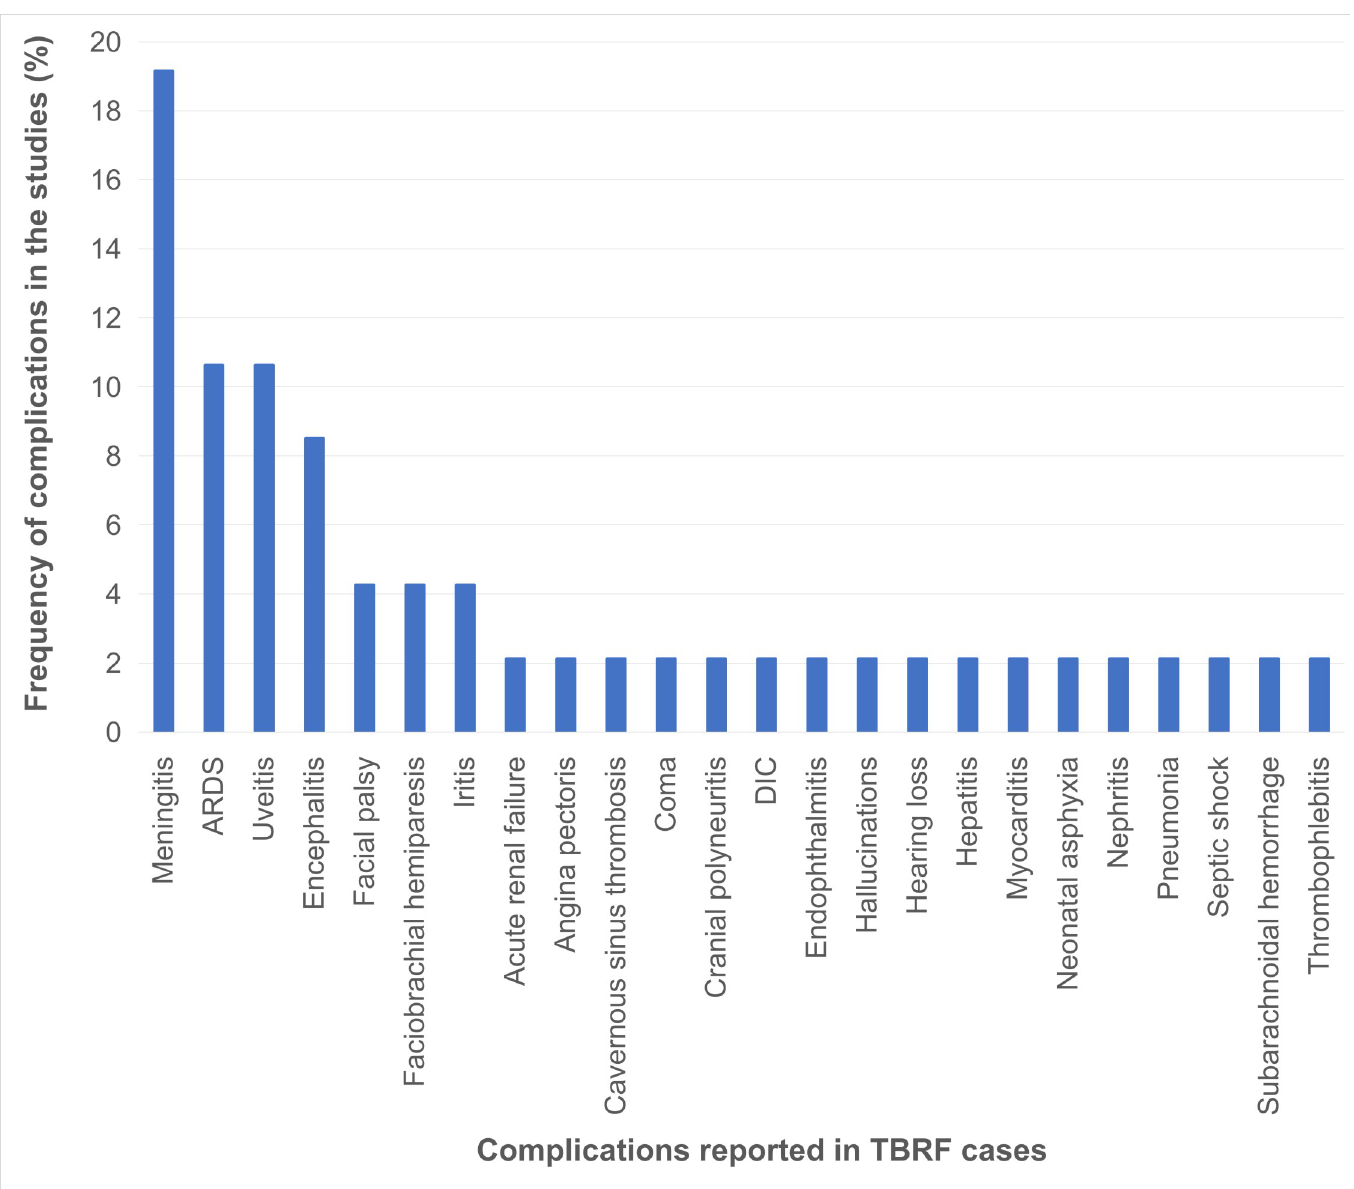
Fig 14. Complications of TBRF (n = 47 studies). ARDS, acute respiratory distress syndrome; DIC, disseminated intravascular coagulation; TBRF, tick borne relapsing fever.